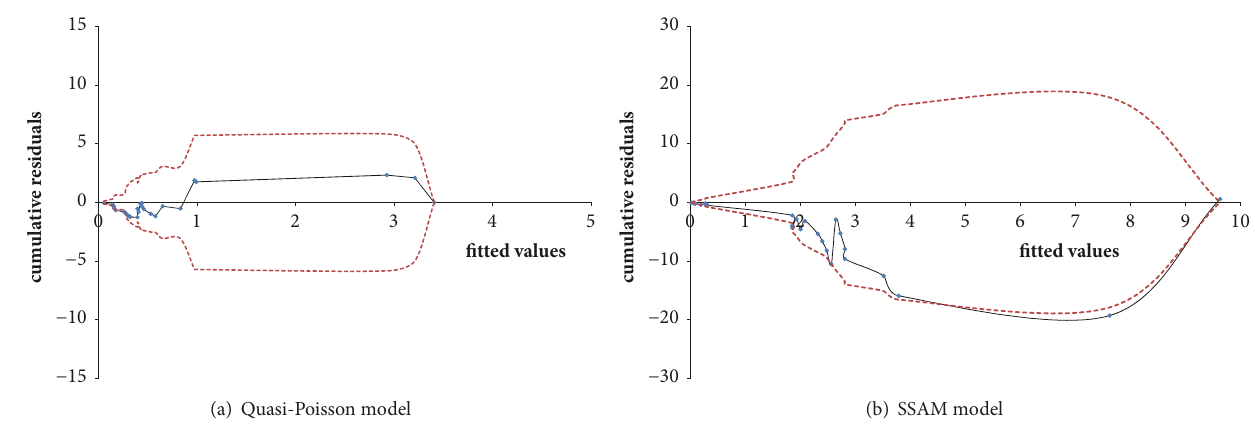
Figure 6: CURE plots for fitted values: a) quasi-Poisson model; b) SSAM